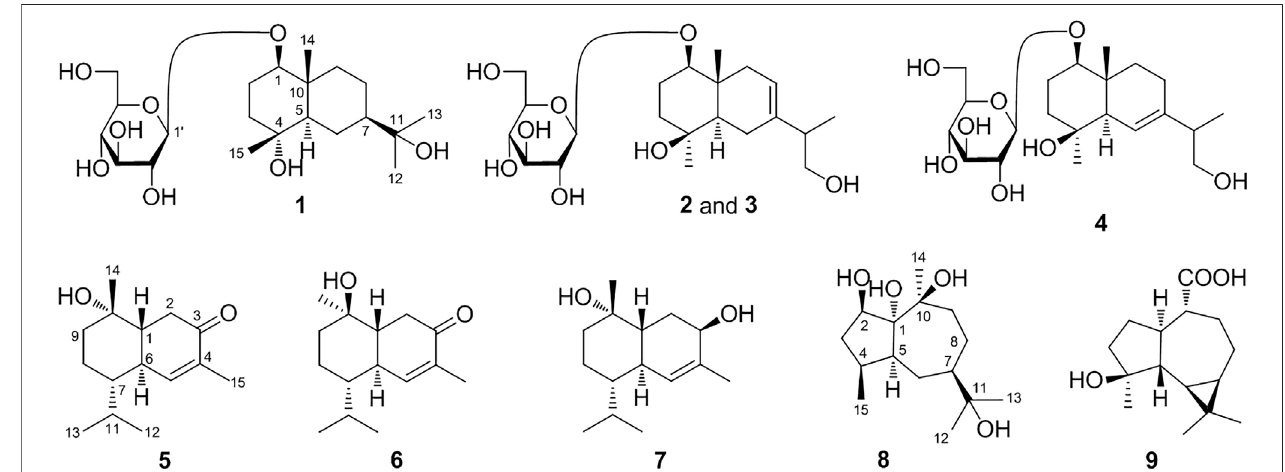
FIGURE 1 | The structures of new sesquiterpenes 1 – 9